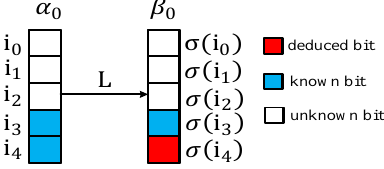
Figure 4: Deducing new differences from the CP-kernel equations.